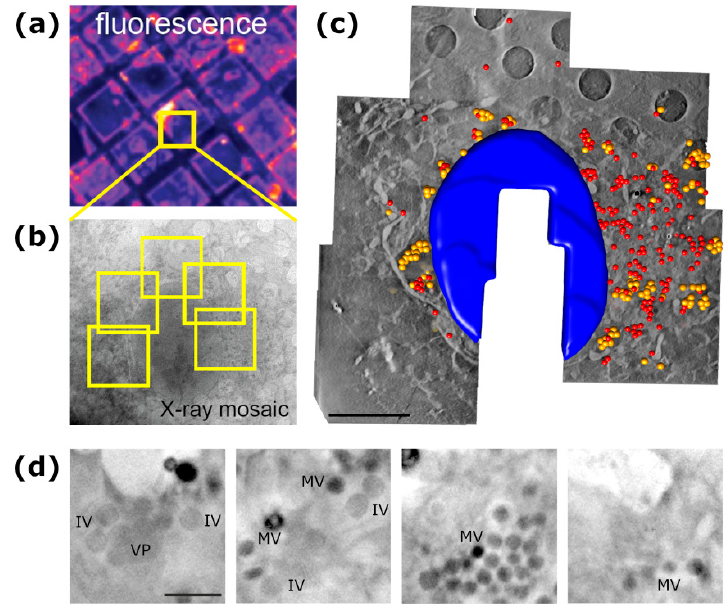
Figure 3. Cartography of the vaccinia virus infection by cryo-SXT. ( a ) Infected cells were located by visible light fluorescence cryo-microscopy. ( b ) X-ray mosaic shows the whole-cell 2D projection used to configure the area of interest. Several tomograms were acquired from the same cell (yellow squares) to obtain a whole-cell tomogram. ( c ) Segmented 3D volume of the whole-cell tomogram. Nucleus is shown in blue; immature virions and mature virions are shown as yellow and red spheres, respectively. Scale bar corresponds to 5 µm. ( d ) Close-up views of different tomograms, where viroplasm (VP), immature virions (IV) and intracellular mature virions (MV) can be observed. Scale bar corresponds to 0.5 µm. Adapted from Chichón et al. [58], with permission from Elsevier.